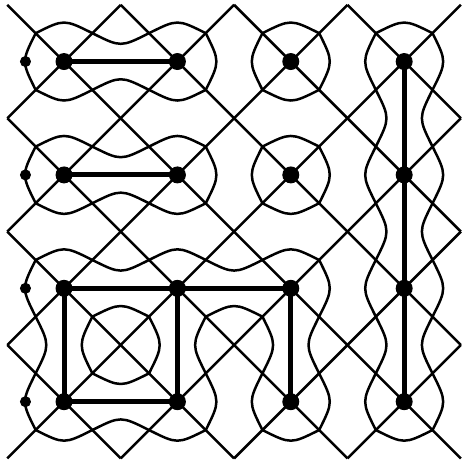
Figure 6 . The blobbed loop model where loops that touch the left boundary at least once (blobbed loops) get a modi(cid:12)ed Boltzmann